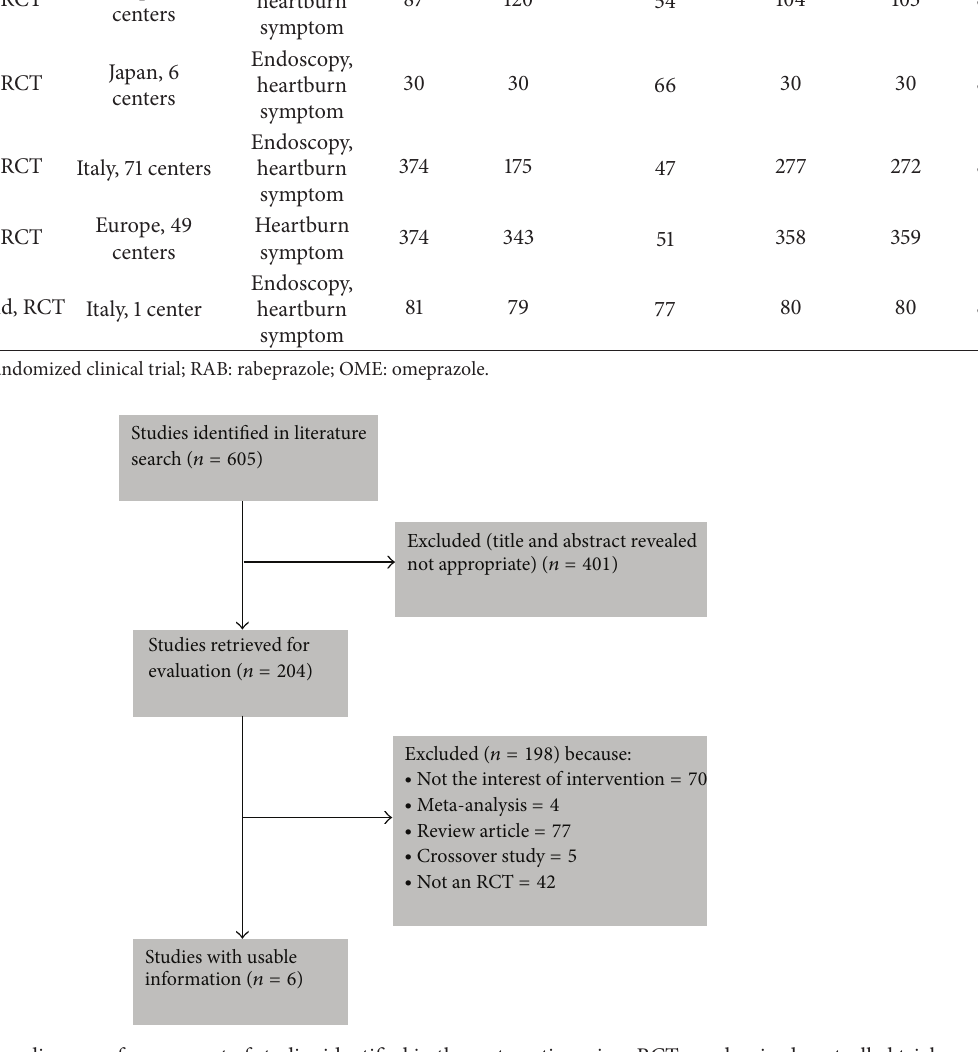
Figure 1: Flow diagram of assessment of studies identified in the systematic review. RCT: randomized controlled